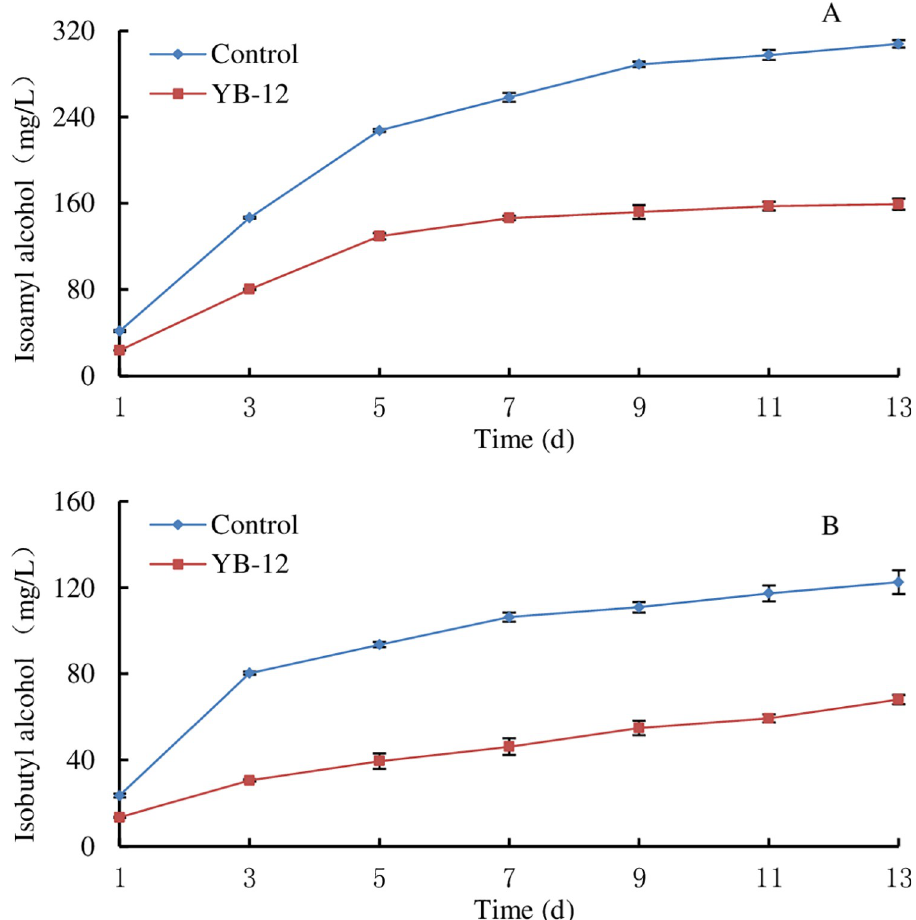
Fig 5. Changes in isoamyl alcohol (A) and isobutyl alcohol (B) during fermentation by YB-12 and the reference strain in a 20 L bioreactor.